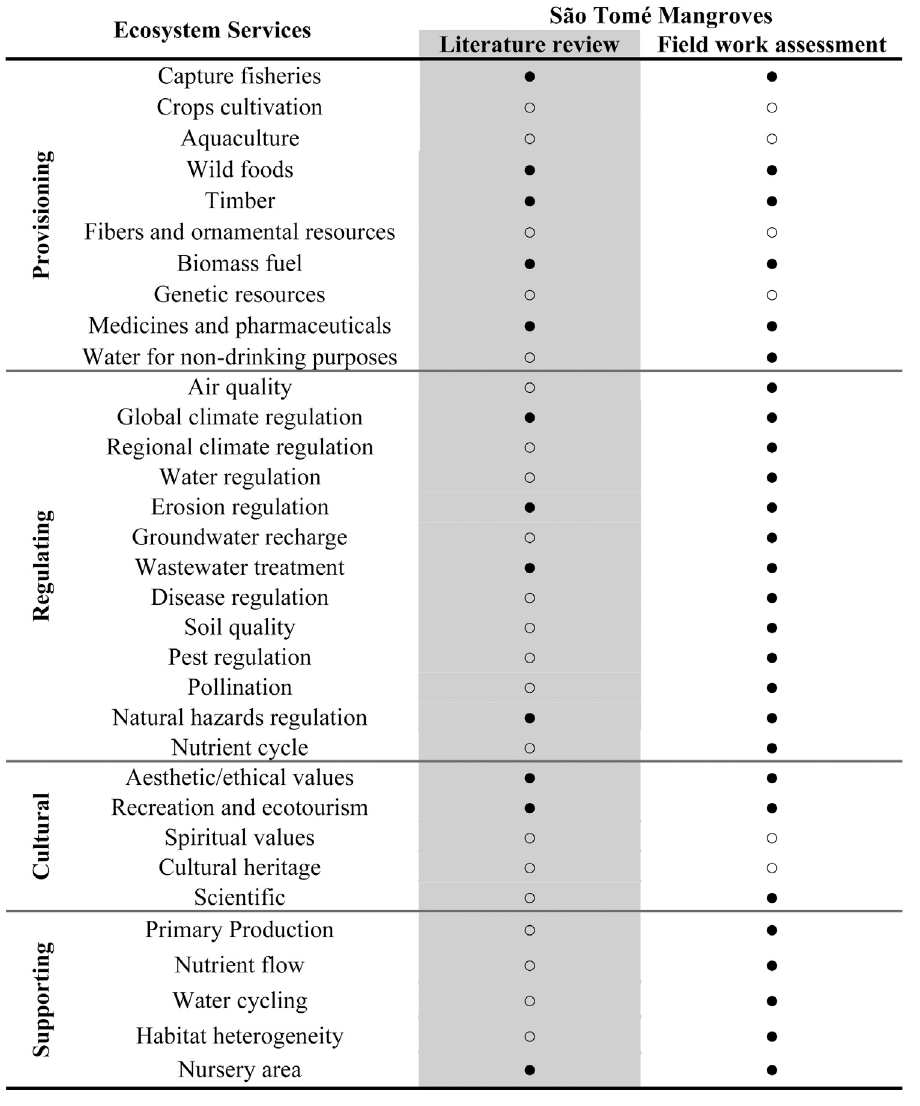
Frontiers in Environmental Science |